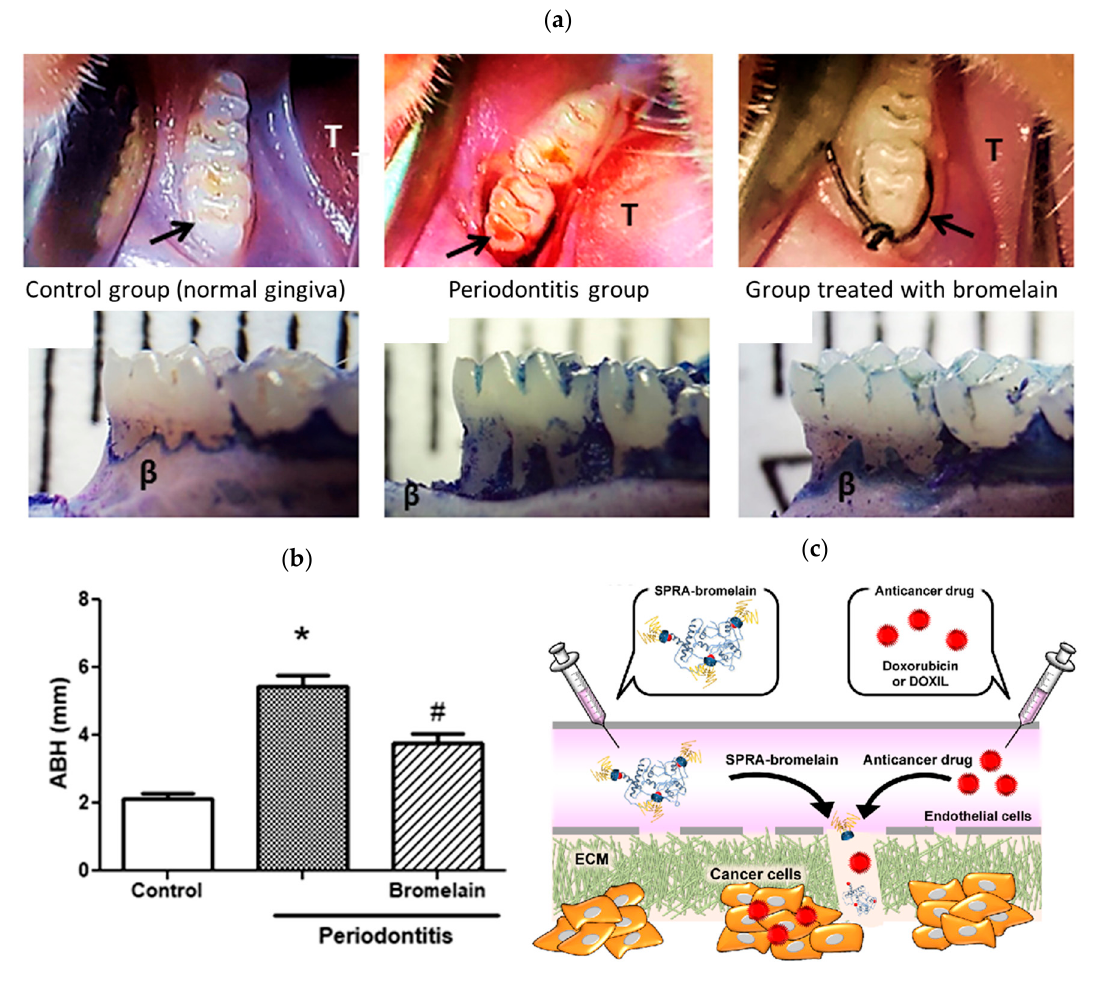
Figure 8. ( a ) Comparison of the control group (normal gingiva), periodontitis group and group treated with bromelain 15 mg/kg (arrow shows the first molar and the letter T shows the tongue). Group treated with bromelain indicates improvement of gingival papilla staining, reduction in edema, absence of bleeding and moderate bone loss (Reproduced with permission from [111], John Wiley and Sons, Hoboken, NJ, USA, 2020); ( b ) morphometric analyses of alveolar bone height; * p < 0.05 indicates the Periodontitis groups versus the Control group and # p < 0.05 indicates the Periodontitis groups versus the Bromelain group (Reproduced with permission from [111], John Wiley and Sons, Hoboken, NJ, USA, 2020); ( c ) the scheme of the SPRA-bromelain suggested a mechanism of ECM-degradation in pancreatic cancer (Reproduced with permission from [121], ACS Publications, Washington, DC, USA, 2020).